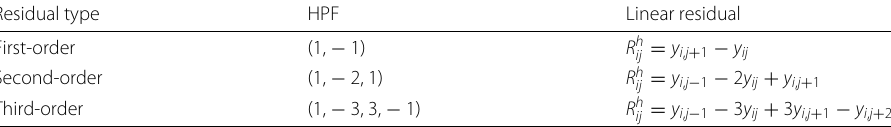
Table 1 First-order, second-order, and third-order linear residuals in the horizontal direction Residual type HPF Linear